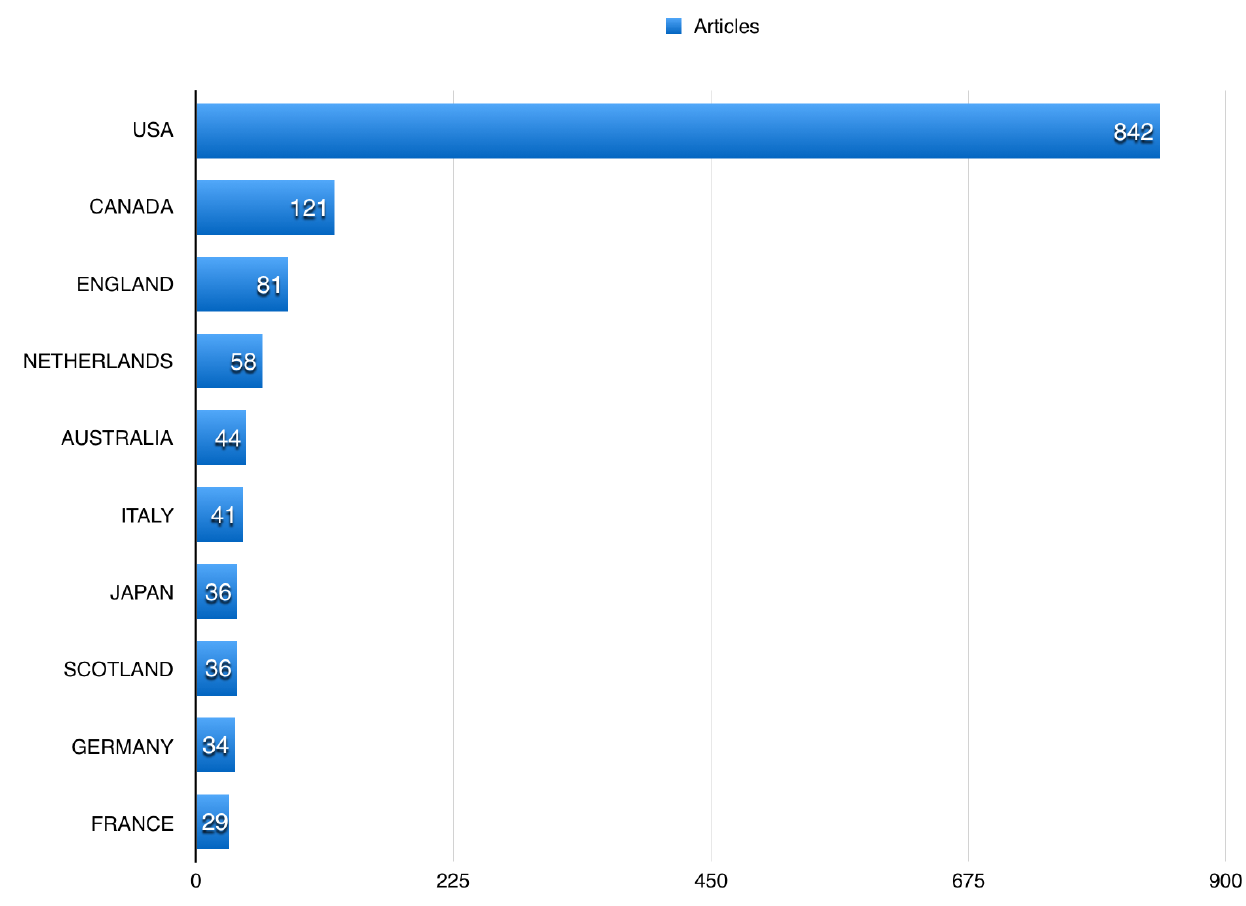
Figure 5. The top countries published using Biologic Specimen and Data Repository Information Coordinating Center (BioLINCC) open